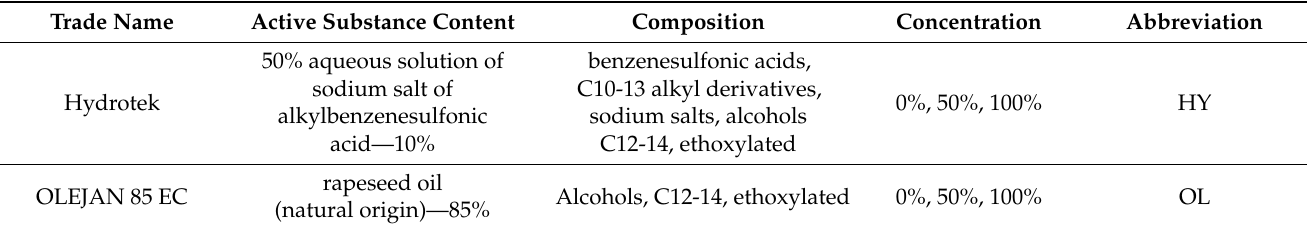
Table 1. Information about the adjuvants used in the tests.